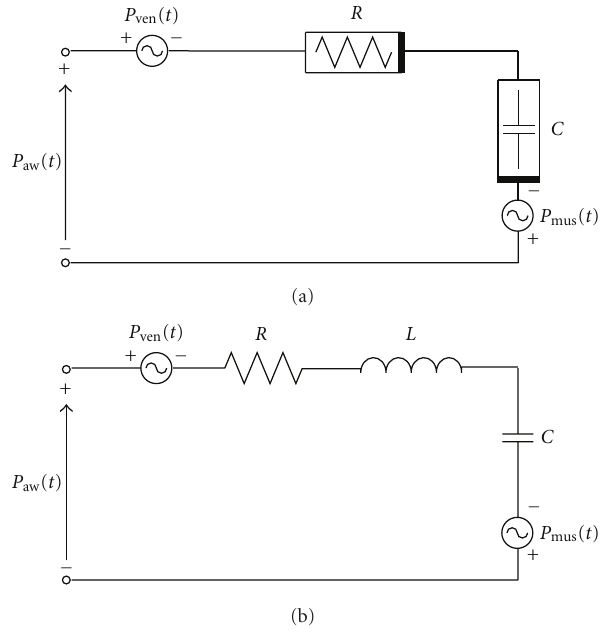
Figure 1: (a) Nonlinear one-compartment respiration model with noninvasive ventilator e ff ect. (b) Linear one-compartment RIC model of the lung with noninvasive ventilator e ff